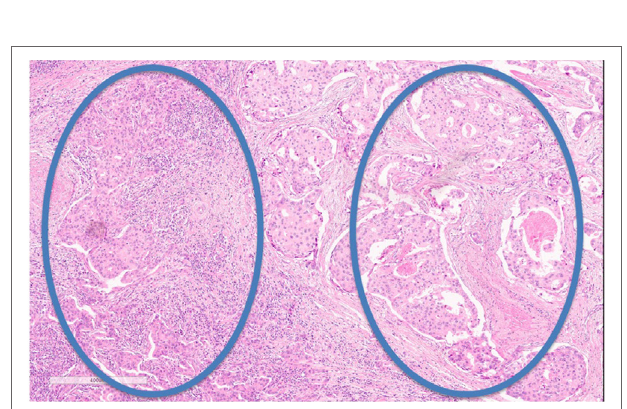
FiGURe 2 | Tumor-infiltrating lymphocyte (TIL) heterogeneity. Zone with high TILs on the left, zone with low TILs on the right. Magnification 100 × .